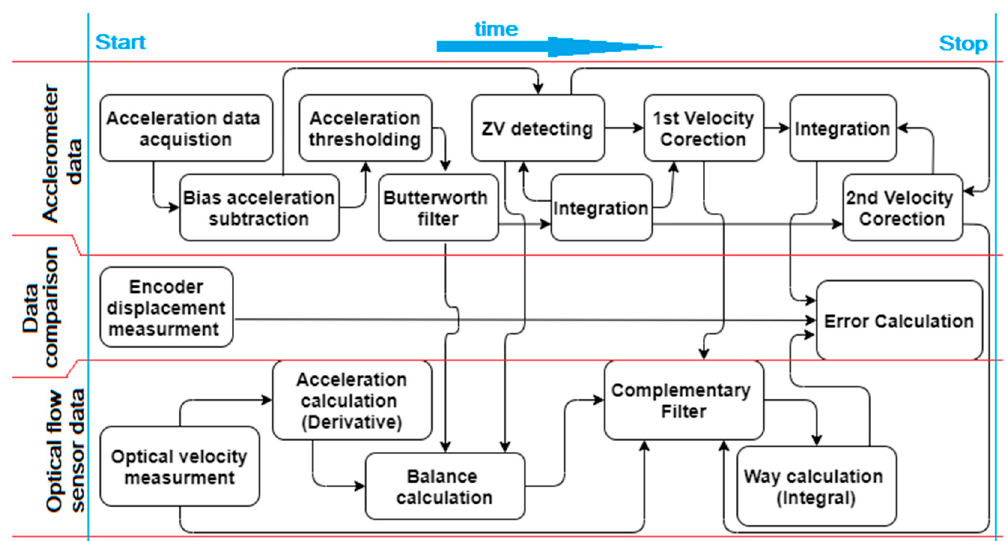
Figure 4. The flowchart of data processing algorithm for displacement (way) estimation concerning the accelerometer, optical flow sensor (OFS), complementary filter, and error calculations in relation to the encoder.